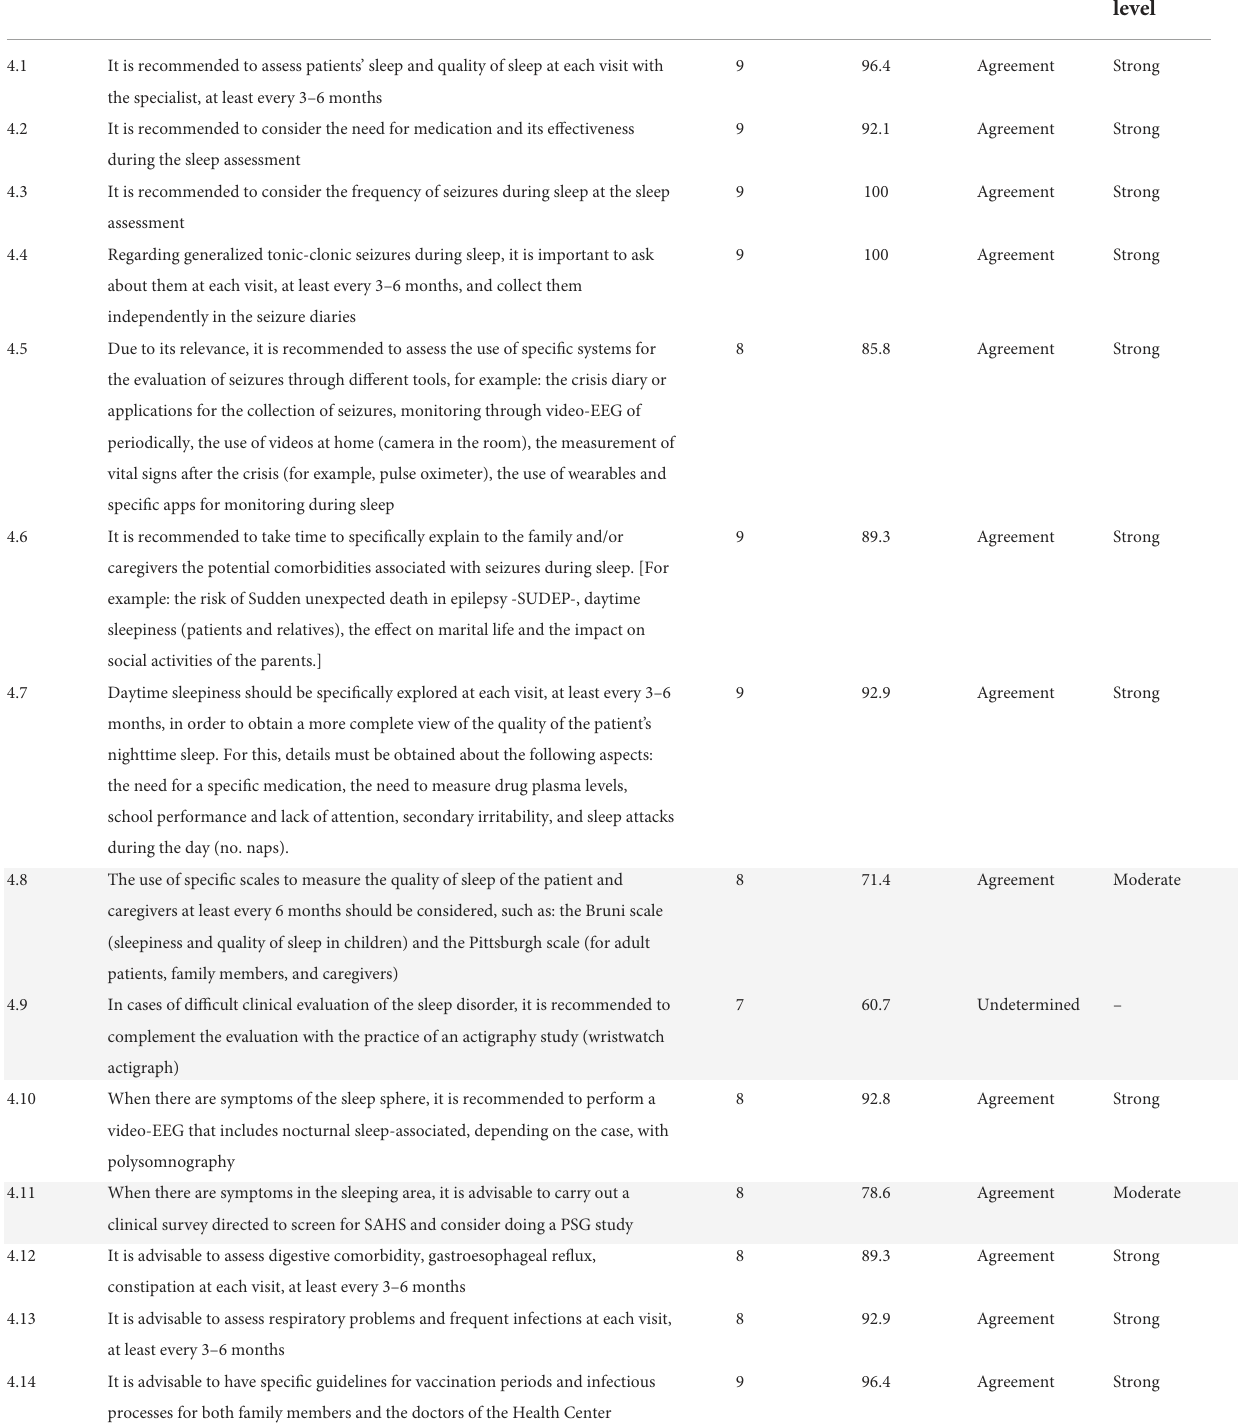
TABLE 4 Evaluation of other comorbidities that affect quality of life in patients with Dravet